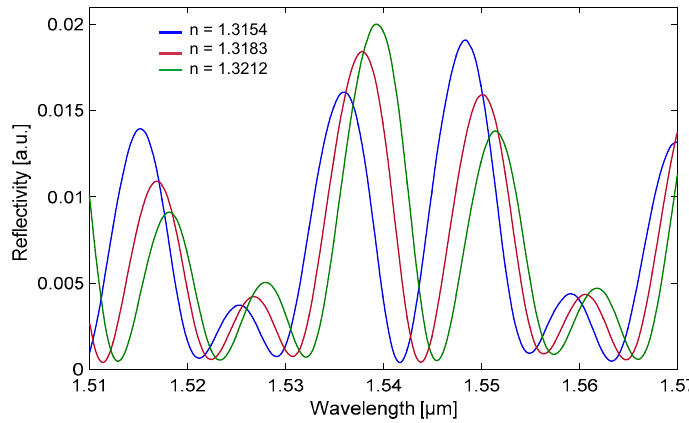
Figure 8. Experimental spectra of the reflected optical power, normalized to the input power spectrum, measured on a rectangular – miniature hollow glass tubing with d = 30 µm, t f = t b = 21 µm (nominal dimensions) filled with glucose-water solutions at three different glucose concentrations C in %(weight/volume). Blue trace: C = 0% [W/V] corresponding to RI = 1.3154, red trace: C = 2% [W/V] corresponding to RI = 1.3183, green trace: C = 4% [W/V] corresponding to RI = 1.3212 (all RI values are calculated as in [35,36]).